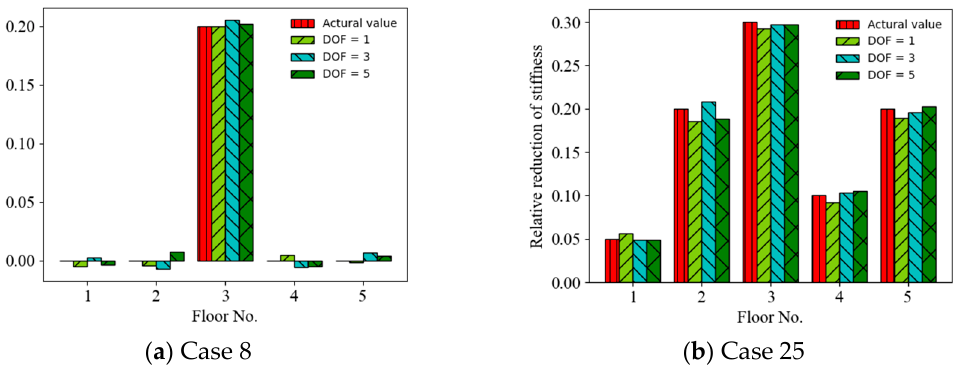
Figure 11. Prediction results of structural damage using acceleration responses from different measurement points as ANN input.